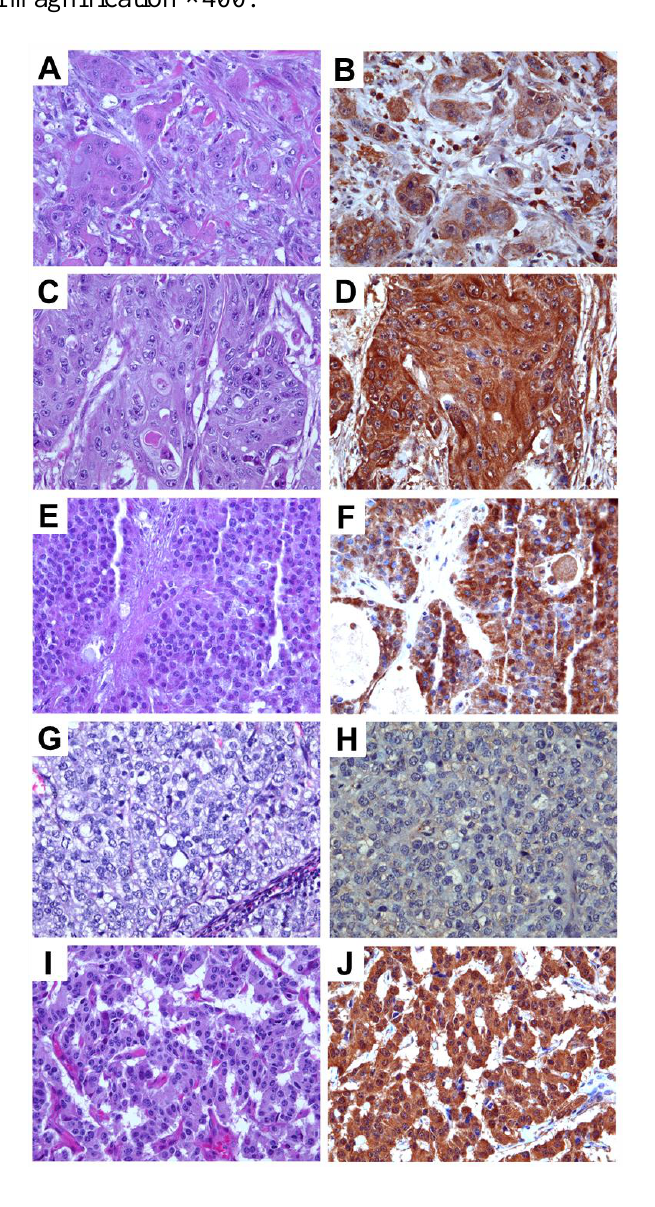
Figure 2. Immunohistochemical analysis of TRPM8 in malignant pancreatic